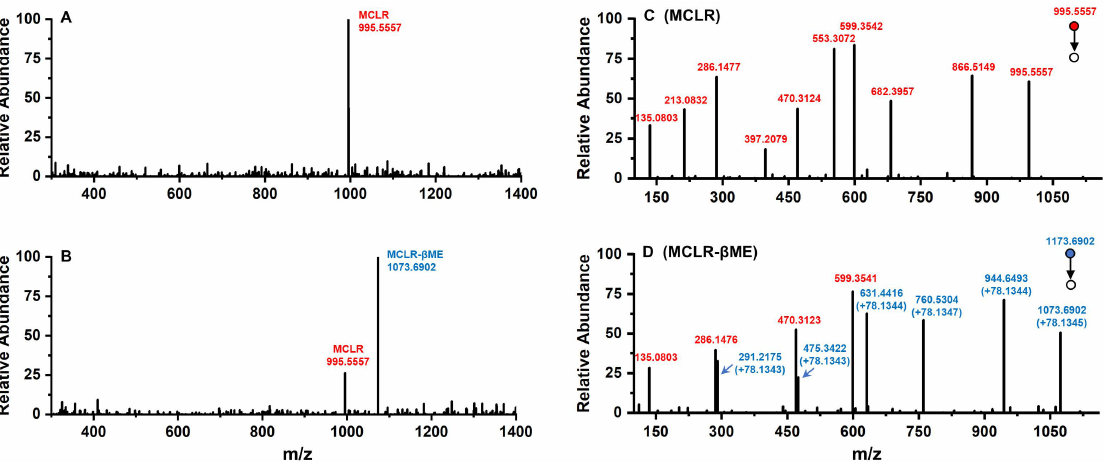
Figure 2. The MS analysis of MCLR and its electrophilic addition product, MCLR- β ME. Conditions: MS spectra for MCLR ( A ) and MCLR- β ME ( B ); MS/MS spectra for MCLR ( C ) and MCLR- β ME ( D